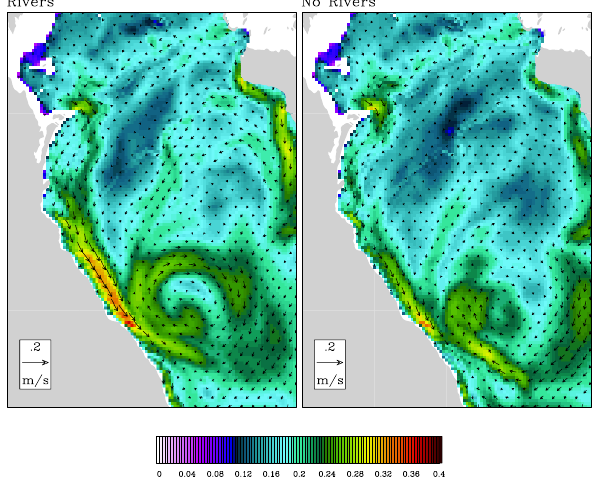
Figure 12. Model surface velocity vector mean and rms vector amplitude over a year’s simulation, with rivers and without rivers. Means are denoted with arrows while rms amplitude is colour con- toured. Every fourth vector is shown in the along-shore and across- shore